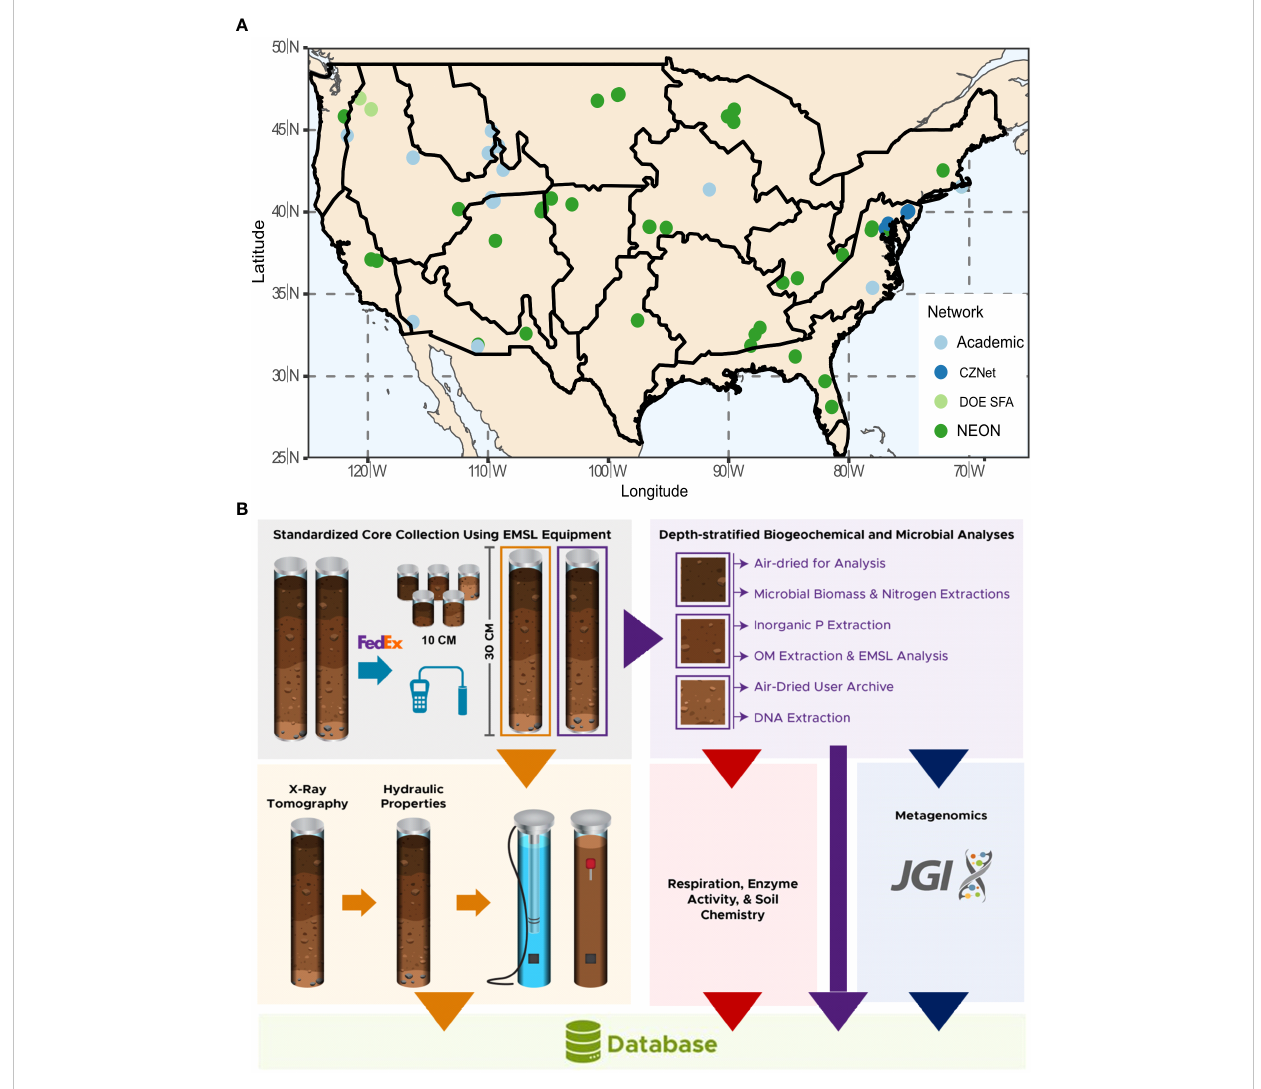
FIGURE 1 (A) Sites included in the 1000 Soils Pilot overlain on National Ecological Observatory Network (NEON) eco-domains. The color of the symbol indicates site af fi liation as Academic (light blue), Critical Zone Network (CZNet; dark blue), Department of Energy Science Focus Area (DOE SFA; light green), and NEON (dark green). (B) Soil core analysis work fl